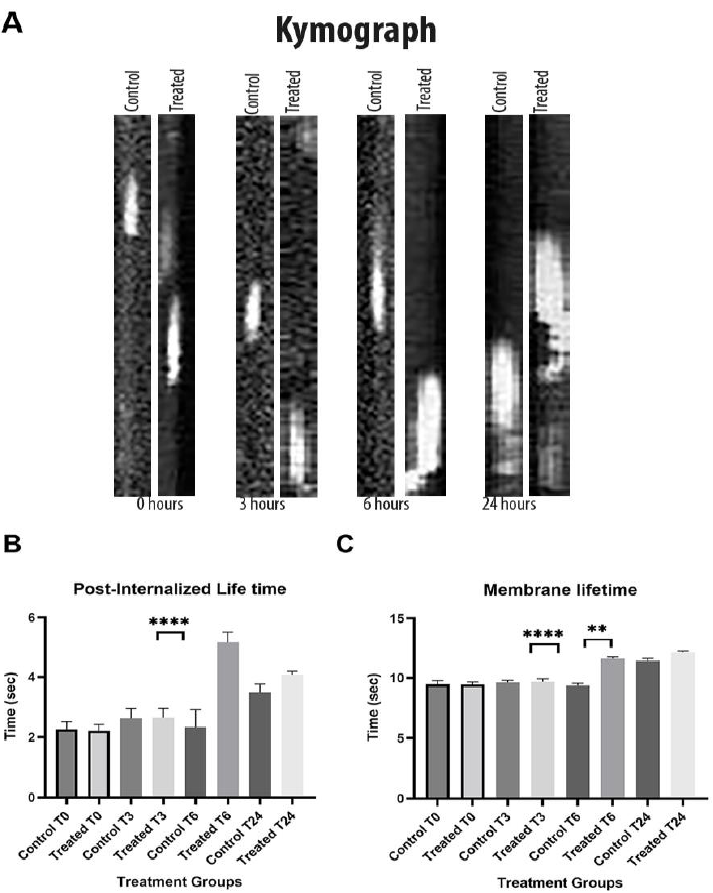
Figure 9. Inefficient endocytosis and prolonged path duration of the endocytosis vesicle resulted from the slowed detachment of Abp1-GFP. ( A ) Kymograph of endocytic vesicle formation showing inefficient endocytosis for groups treated with 25 µ g/mL of CdSe/ZnS at 0 h, 3 h, 6 h, and 24 h post-treatment. ( B ) Prolonged lifetime of Abp1-GFP on the plasma membrane. ( C ) Lifetime of Abp1-GFP post-membrane detachment. ** p < 0.01, **** p < 0.0001 .